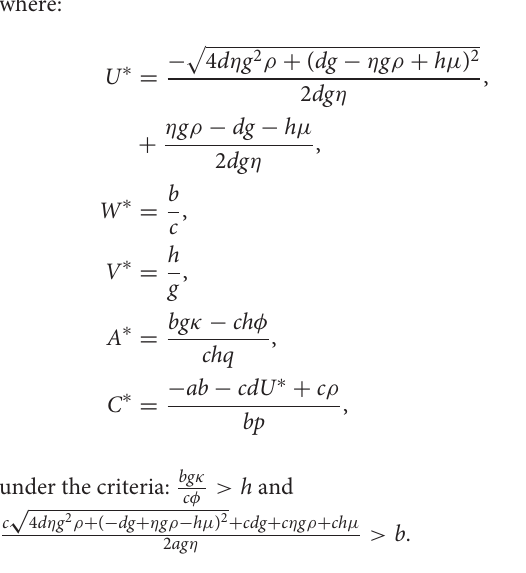
Frontiers in Molecular Biosciences |